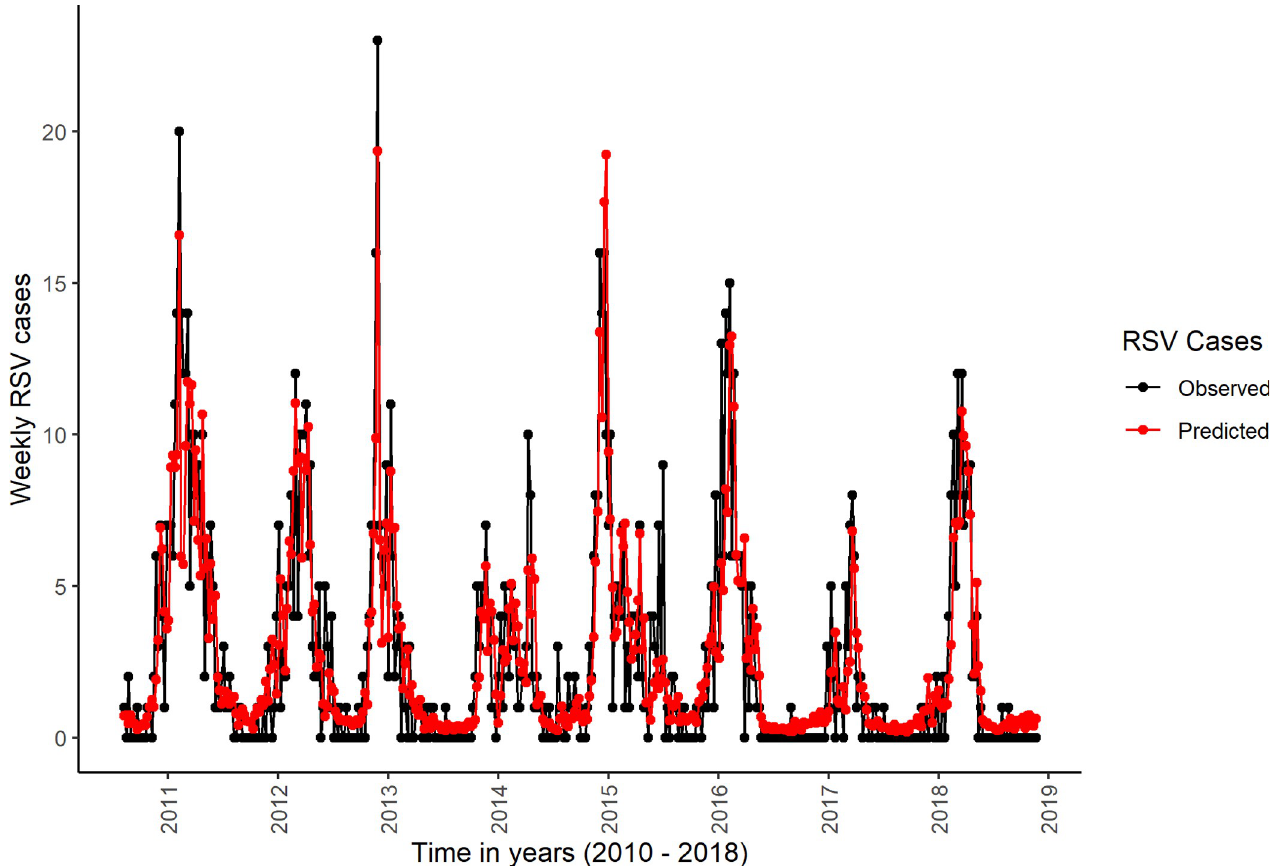
Fig 4. Plot of observed and predicted weekly RSV cases in the first imputed 2010–2018 dataset. The black line connects the observed weekly RSV cases while the red line connects the predicted weekly RSV